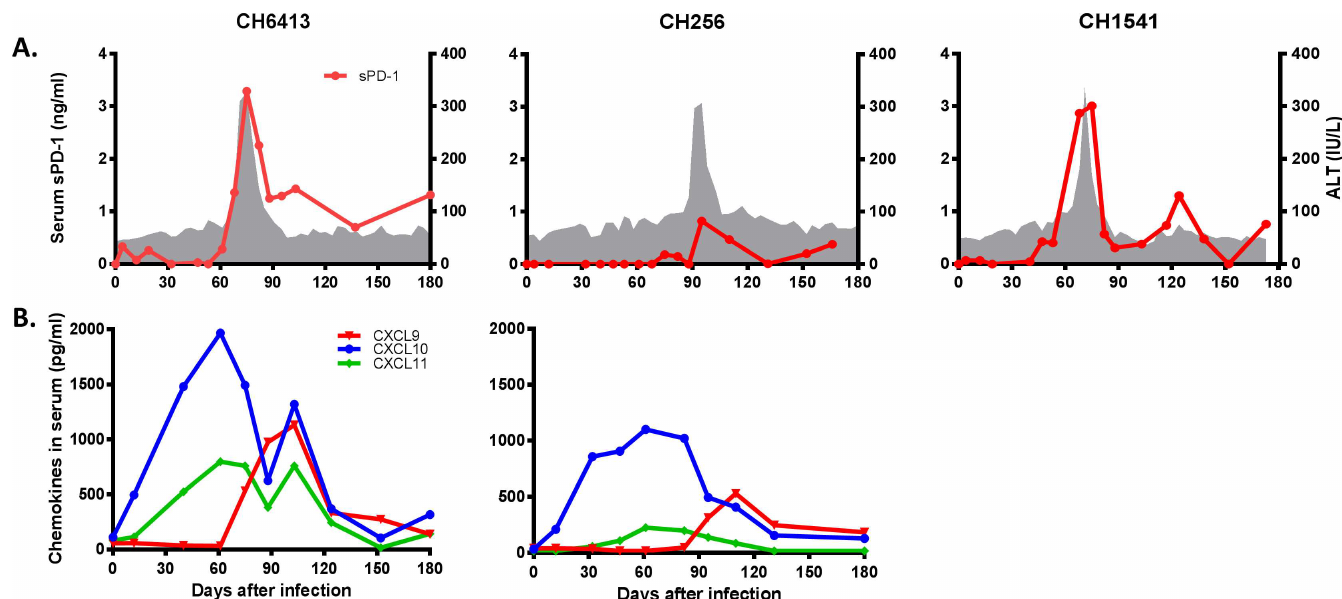
Fig 3. Serum levels of sPD-1 and chemokines. (A) Levels of serum sPD-1 (red line) were compared to ALT activity (gray shading). (B), serum levels of CXCL9 (red line), CXCL10 (blue line), and CXCL11 (green line) in CH6413and CH256. Serum samples of CH1541were not availableso serum levels of chemokines by ELISA analysis could not be